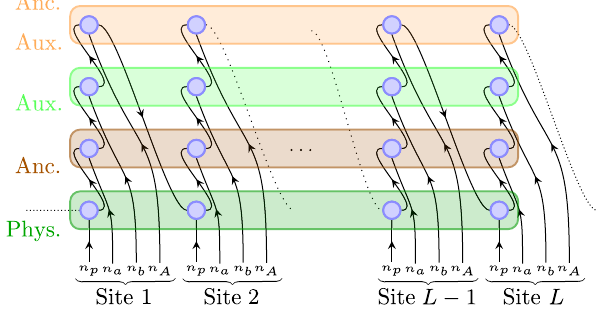
FIG. 17. Structure of MPS for thermal-state calculations using state purification and imaginary-time evolution via TDVP, which requires introducing ancilla sites. The use of the SYMMPS package [62] for TDVP also requires using PP-DMRG [60], meaning adding auxiliary sites for both physical and ancilla sites to recover conserved charge and spin quantum